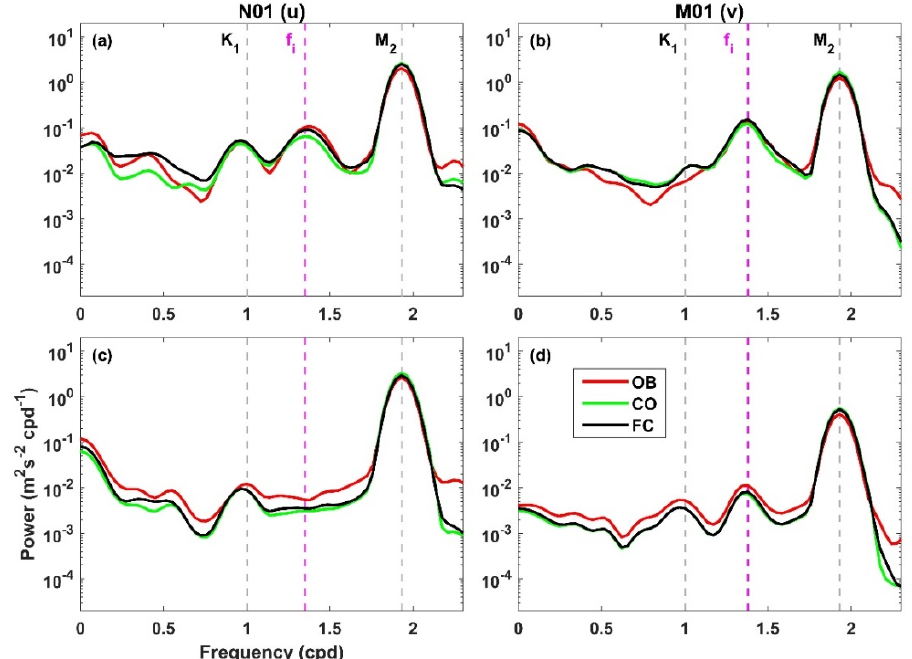
Figure 4. Power spectra for time series of the zonal velocity near the ( a ) surface and ( c ) bottom layers at station N01 and the meridional velocity near the ( b ) surface and ( d ) bottom layers at station M01 based on observations (OB) and mode results (runs CO and FC). Dashed lines mark the tidal (K 1 and M 2 ) and inertial frequencies ( f i